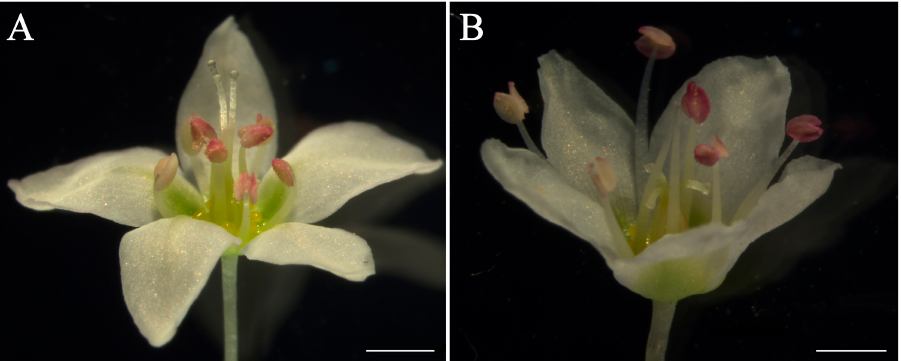
Figure 1. Heterodistylous flowers of F. esculentum . ( A ) pin flower with long pistil and short stamens; ( B ) thrum flower with short pistil and long stamens. Scale bar = 1 mm.